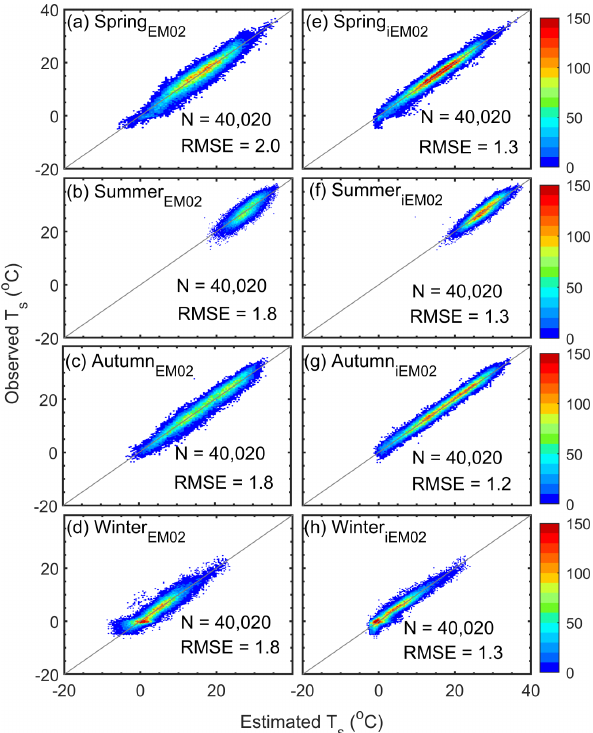
Figure 7. Seasonal comparison between the estimated and observed soil temperatures. (a–d) The empirical model (EM). (e–h) The im- proved empirical model (iEM02). RMSE was calculated as the root mean square error between estimated and observed soil tempera- ture. N refers to the sample size, and the gray line represents the 1 : 1 line. The color bar describes the number of data